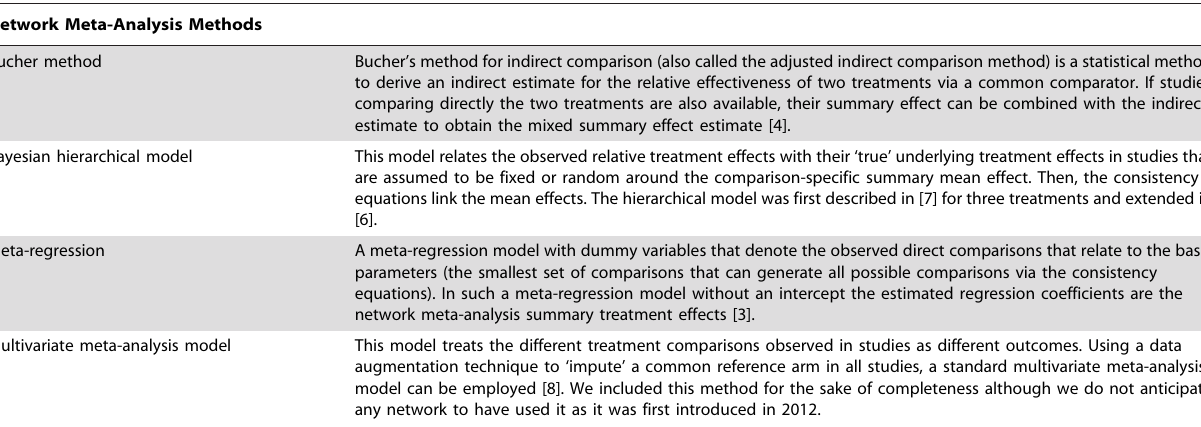
Table 1. Description of methods to derive indirect and mixed estimates.